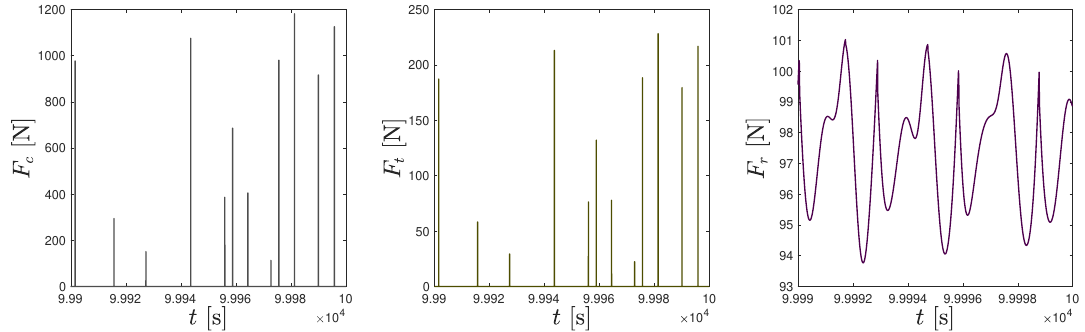
Figure 12. Investigated system’s (1) forces F c , F t , and F r for e T = 0.015 m, ω = 2.2 rad s − 1 , and z a = 0.0028